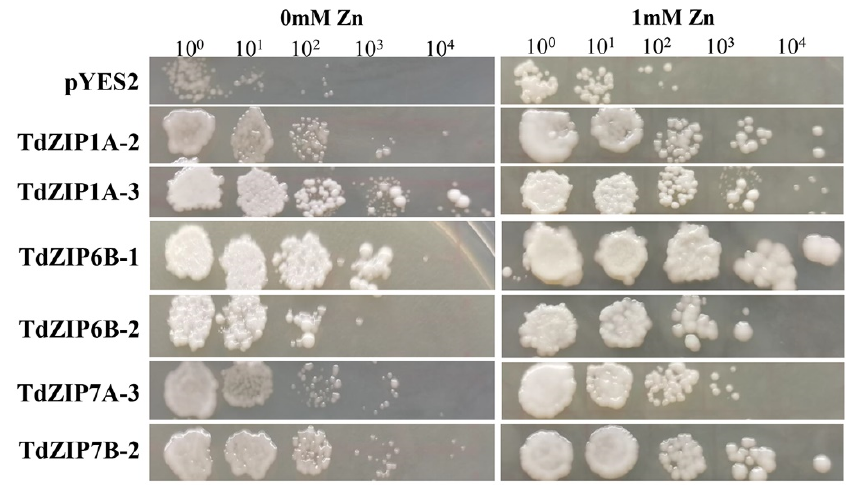
Figure 3. Complementation of yeast Zn uptake mutant ( zrt1 / zrt2 ∆ ) with TdZIP genes under different Zn concentrations. The yeast zrt1 / zrt2 ∆ mutant transformed with the empty vector pYES2 was used as a negative control. Each spot represents a 1:10 dilution of the culture starting with an OD of 0.5 on the far left (10-, 100-, 1000-, 10,000-fold dilutions).